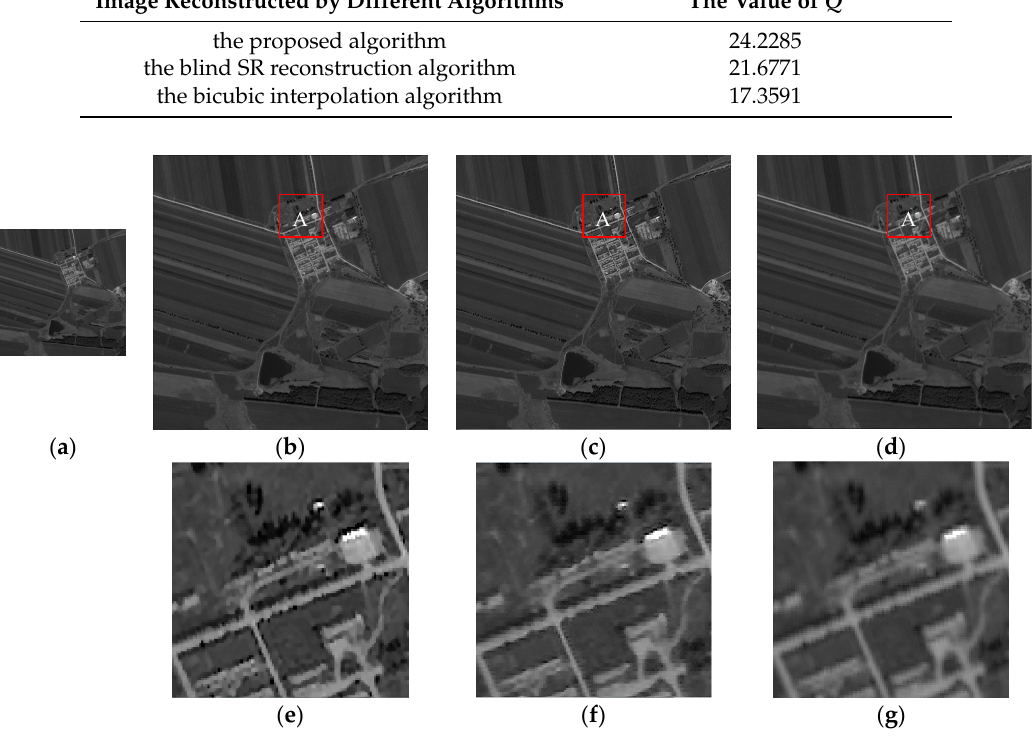
Table 6. The nominal values of metric Q of three reconstructed images in the first set of experiments. Image Reconstructed by Different Algorithms